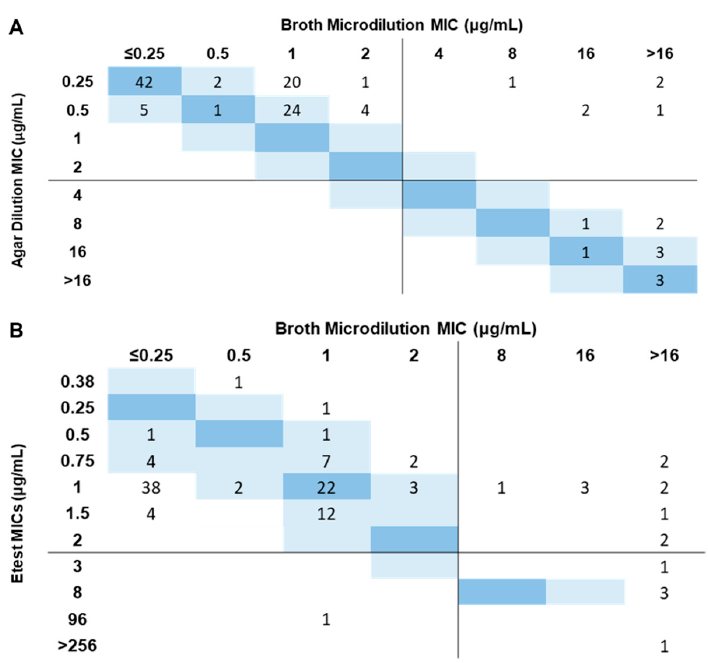
Figure 2. Correlation between the reference method, broth microdilution, and AD ( A ) or MTS ( B ). Blue rectangles represent the number of isolates within the MIC essential agreement range where the darker ones represent the number of isolates with the same MIC and the light ones the number of isolates within ±1 two-fold change. The black lines separate the susceptible ( ≤ 2 μ g/mL) and resistant (>2 μ g/mL) phenotypes according to EUCAST breakpoints [22].